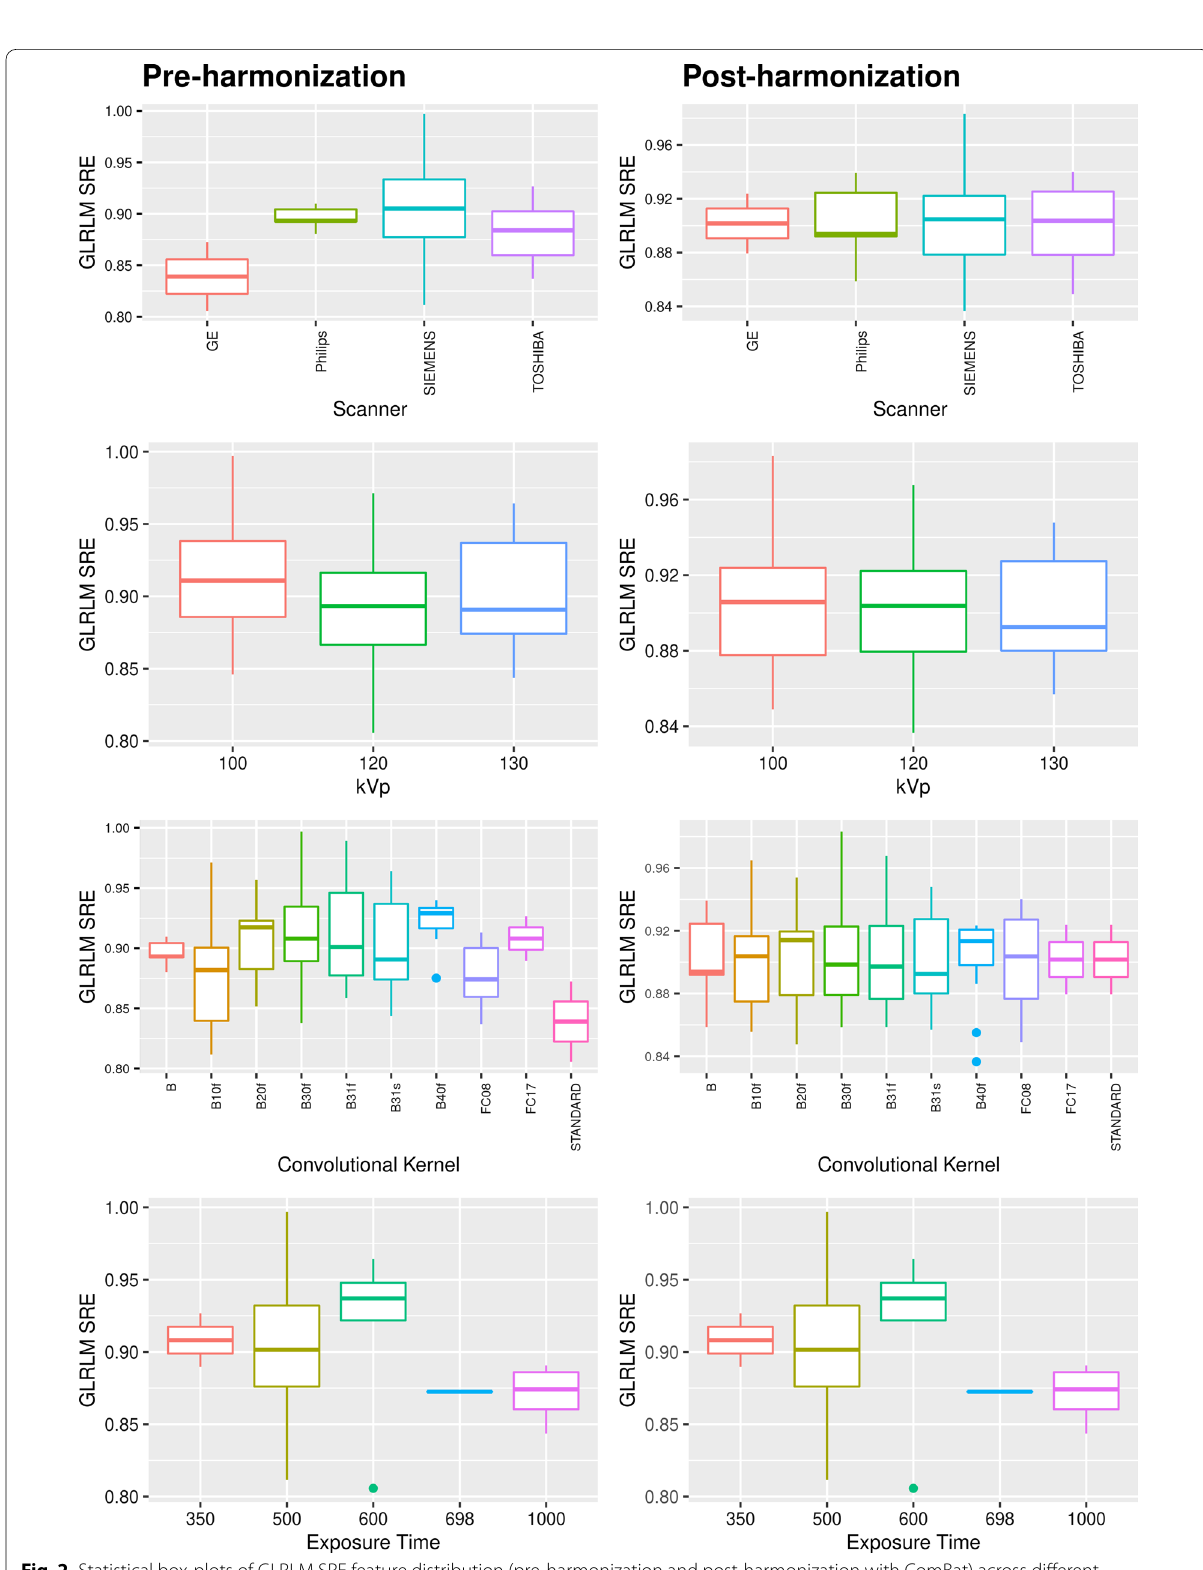
Fig. 2 Statistical box-plots of GLRLM SRE feature distribution (pre-harmonization and post-harmonization with ComBat) across different image-acquisition parameters: Scanner, kVp, Convolutional Kernel, Exposure